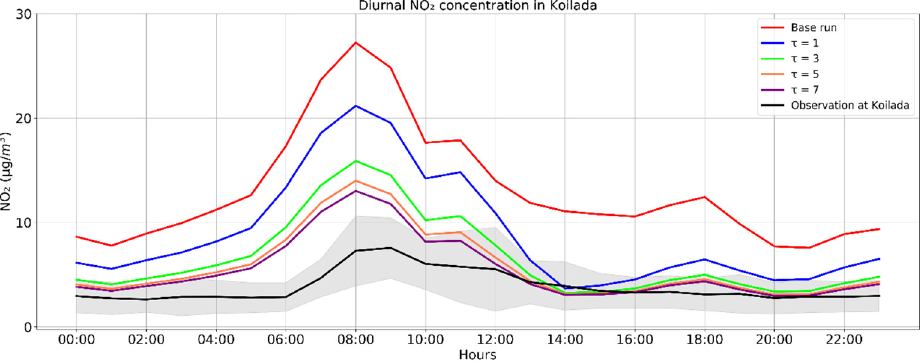
Figure A2. Diurnal cycle of the assimilated NO 2 simulations in July 2019 from the sensitivity tests using τ values of 1, 3, 5 and 7 days [different colored lines] in the grid pixel where Koilada air quality station and Ag. Dimitrios power plant are located. The black line denotes the in situ measurement of Koilada station, with the associated standard deviation shown as a grey shaded area, while the red line the base run performed.